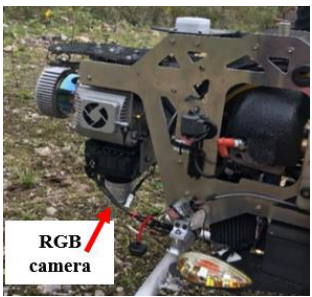
Figure 4. RGB camera mounted on UAV in 2018 flight campaign